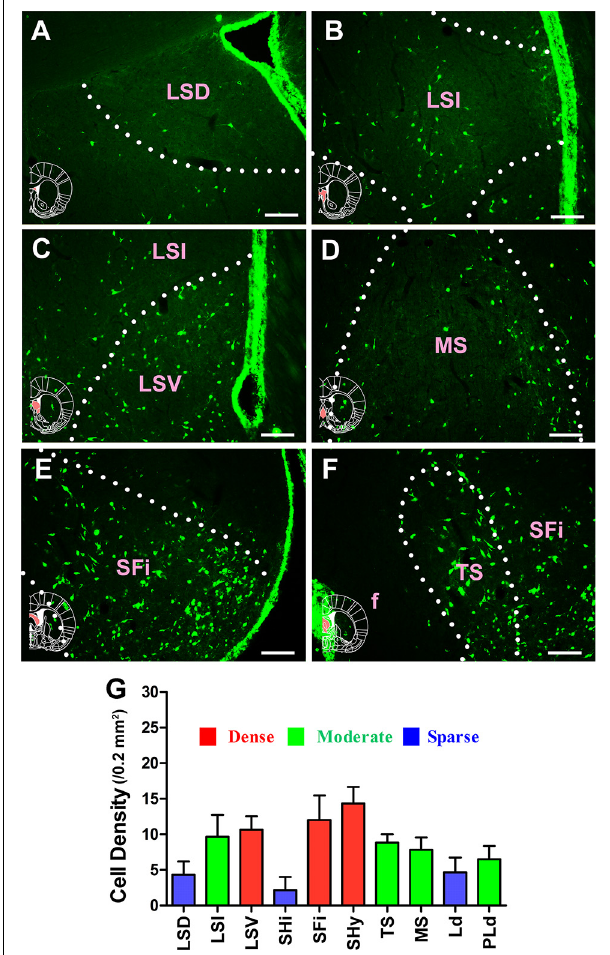
FIGURE 4 | Distribution of cholera toxin subunit B-positive neurons in the septum. (A–F) The positive neurons in LSD, LSI, LSV, MS, SFi, and TS. (G) Statistics of the input amounts of cholera toxin subunit B-positive cells from the septum to the CSF-contacting nucleus (mean ± SD, n = 6; LSD, lateral septal nucleus dorsal part; LSI, lateral septal nucleus intermediate part; LSV, lateral septal nucleus ventral part; MS, medial septal nucleus; SFi, septofimbrial nucleus; TS, triangular septal nucleus; f, fornix). Bar = 100 µ m.